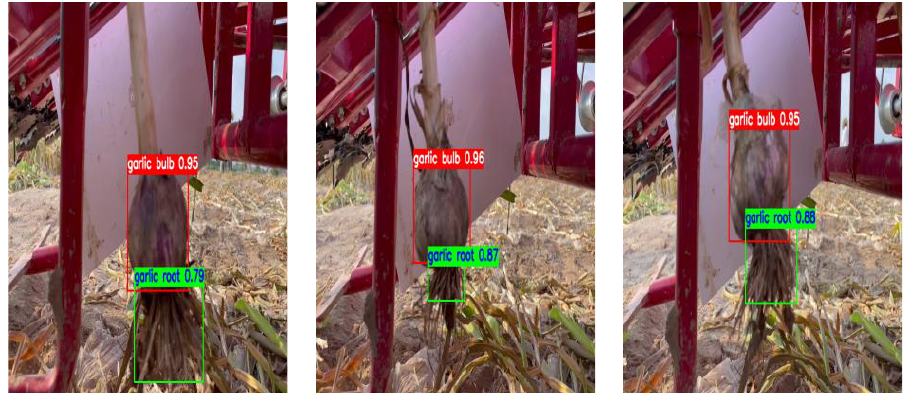
Figure 16. Detection results.